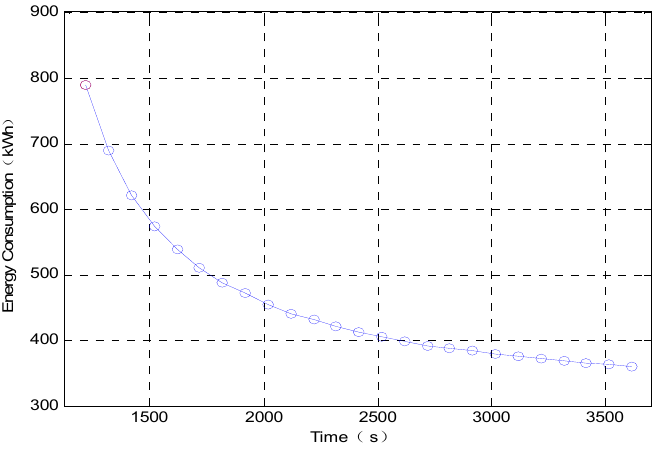
Figure 8. Equidistant speed profiles with various running times.